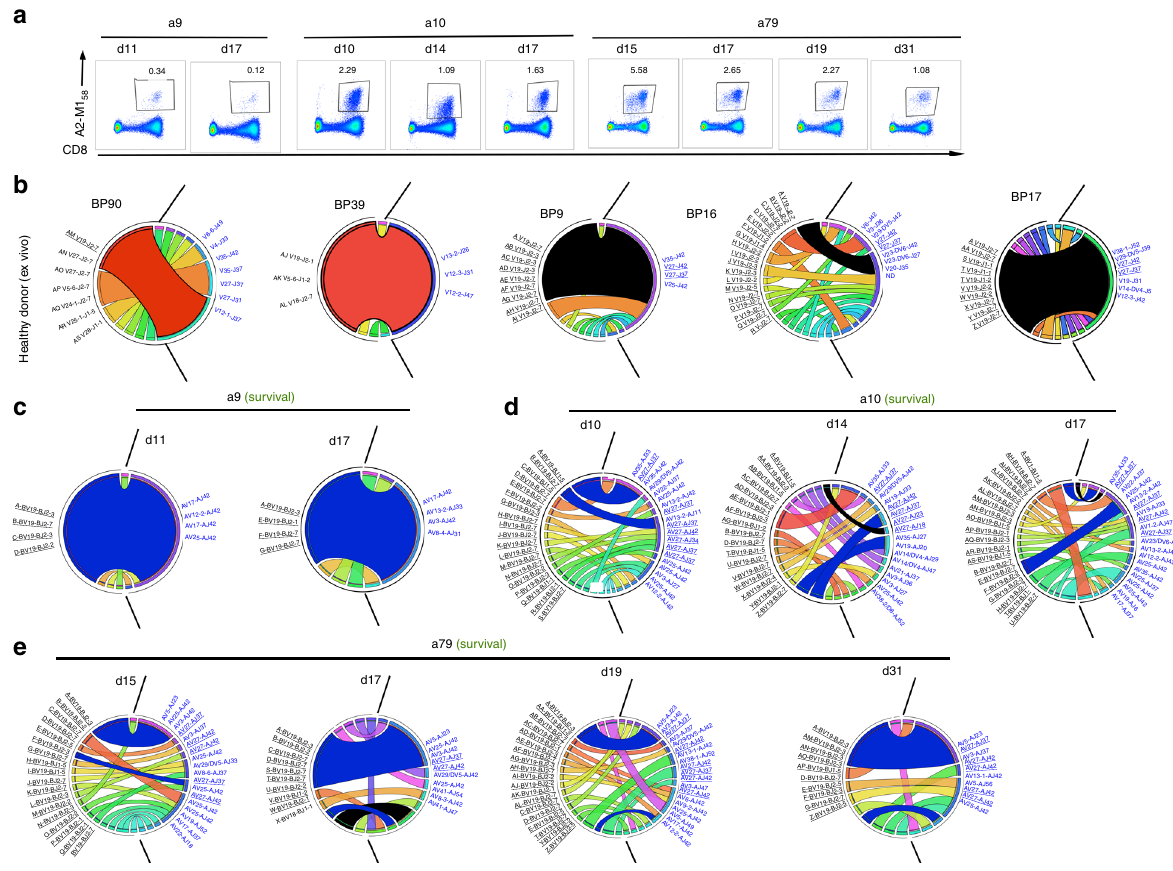
Fig. 3 TCR αβ repertoire diversity and stability within A2-M1 58 + CD8 + T cells in H7N9. a FACS pro fi les are shown for A2-M1 58 + CD8 + T cells after tetramer staining directly ex vivo for a9, a10, and a79 patients. A2-M1 58 + CD8 + T cells were single cell-sorted for TCR αβ repertoire analysis using a multiplex RT- PCR and sequencing. Populations were gated on viable Dump − tetramer + CD3 + CD8 + events. Circos plots of frequencies of V β -J β (in black) and V α -J α (in blue) usage in paired TCR αβ sequences are shown for b memory A2-M1 58 + CD8 + T cells in fi ve healthy donors at one time-point or c – e activated A2- M1 58 + CD8 + T cells in hospitalized patients (a9, a10, and a79) at different time-points after in fl uenza infection. The width of the band is proportional to the frequency and each band represents a unique clone. Red segments represent private dominant A2-M1 58 -speci fi c TCR clones, black segments represent public A2-M1 58 -speci fi c TCR clones. Blue segments represent private dominant A2-M1 58 -speci fi c TCR clones present across different time-points in the H7N9 patients. Prominent TRBV19 and TRAV27 segments are underlined. Circos plots were generated with the Circos software package 40 we found a bias towards TCR β variable 19 (TRBV19) gene usage, persisted through subsequent time-points (Fig. 3c – e) bearing coupled with a dominant TCR α variable 27 (TRAV27) (Fig. 3). similar CDR3 β and/or CDR3 α motifs to the public TCR The frequency of TRBV19 per patient repertoire across the time- clonotype (Supplementary Table 1 – 3). In patient a9, the majority points was 100% for patient a9 (Supplementary Table 1), 95% for of the observed TCR αβ clones consisted of a single clonotype, “ A ” , CDR3 β -SMRSTDTQ/CDR3 α -DGGGGSQGNL at d11 and a10 (Supplementary Table 2), and 99% for a79 (Supplementary + + CD8 Table 3). However, in contrast to memory A2-M1 58 d15 (>70%), with the common “ RS ” motif within the CDR3 β and T cells from healthy individuals 15 , in whom TRBV19 pre- encompassing the public CDR3 α -GGSQGNL sequence (Supple- dominantly paired with TRAV27 (with a mean of 43.2%), the A2- mentary Table 1; Supplementary Fig. 2). In patient a10, two M1 58 + -speci fi c TRBV19s detected at the acute phase of H7N9 CDR3 αβ clonotypes A, B were found at three time-points (d10, infection commonly paired with a range of different TRAVs, with d14, and d17), while an additional seven CDR3 αβ clonotypes TRAV27 being generally found at lower frequencies such as 10% were found at two time-points (Supplementary Table 2; Supple- in a9, 20% in a10, and 23% in a79 T cells, (Fig. 3c – e). A unique mentary Fig. 2). Similarly, in patient a79, clonotype A CDR3 β - feature of this H7N9 cohort was that a public common TCR αβ SGRSADTQ/CDR3 α -DNQGGKL was found at four time-points signature observed previously across healthy donors 15,20 , with a (d15, d17, d19, and d31) and an additional eight CDR3 αβ predominant TCR αβ phenotype [complementarity-determining clonotypes were observed at least at two time-points (Supple- region (CDR3) β -SIRSSYEQ within TRBV19 and CDR3 α - mentary Table 3; Supplementary Fig. 2). + CD8 + TCR αβ repertoire GGSQGNL within TRAV27], was found only in two H7N9 Thus, the tetramer-speci fi c A2-M1 58 is stable during acute H7N9 infection, with the clonal diversity patients at very low frequencies, namely patient a10 at two time- that is at least comparable to that found for memory A2- points (at ~3 – 5%) and a79 at one time-point (13%), which is M1 58 + CD8 + T cells in healthy individuals (Fig. 3b) 15 . lower than the frequency in memory CD8 + T cells from healthy donors (15% for BP16, 62% for BP17, and 67% for BP9; Fig. 3b). Rather, in all the surviving patients, large A2-M1 58 + CD8 + T- Distinct clonal expansions within CD38 + HLA-DR + CD8 + cell clonal expansions were apparent early during infection and T cells . Given differential CD38 + HLA-DR + CD8 + T-cell NATURE COMMUNICATIONS | (2018) 9:824 | DOI: 10.1038/s41467-018-03243-7 |